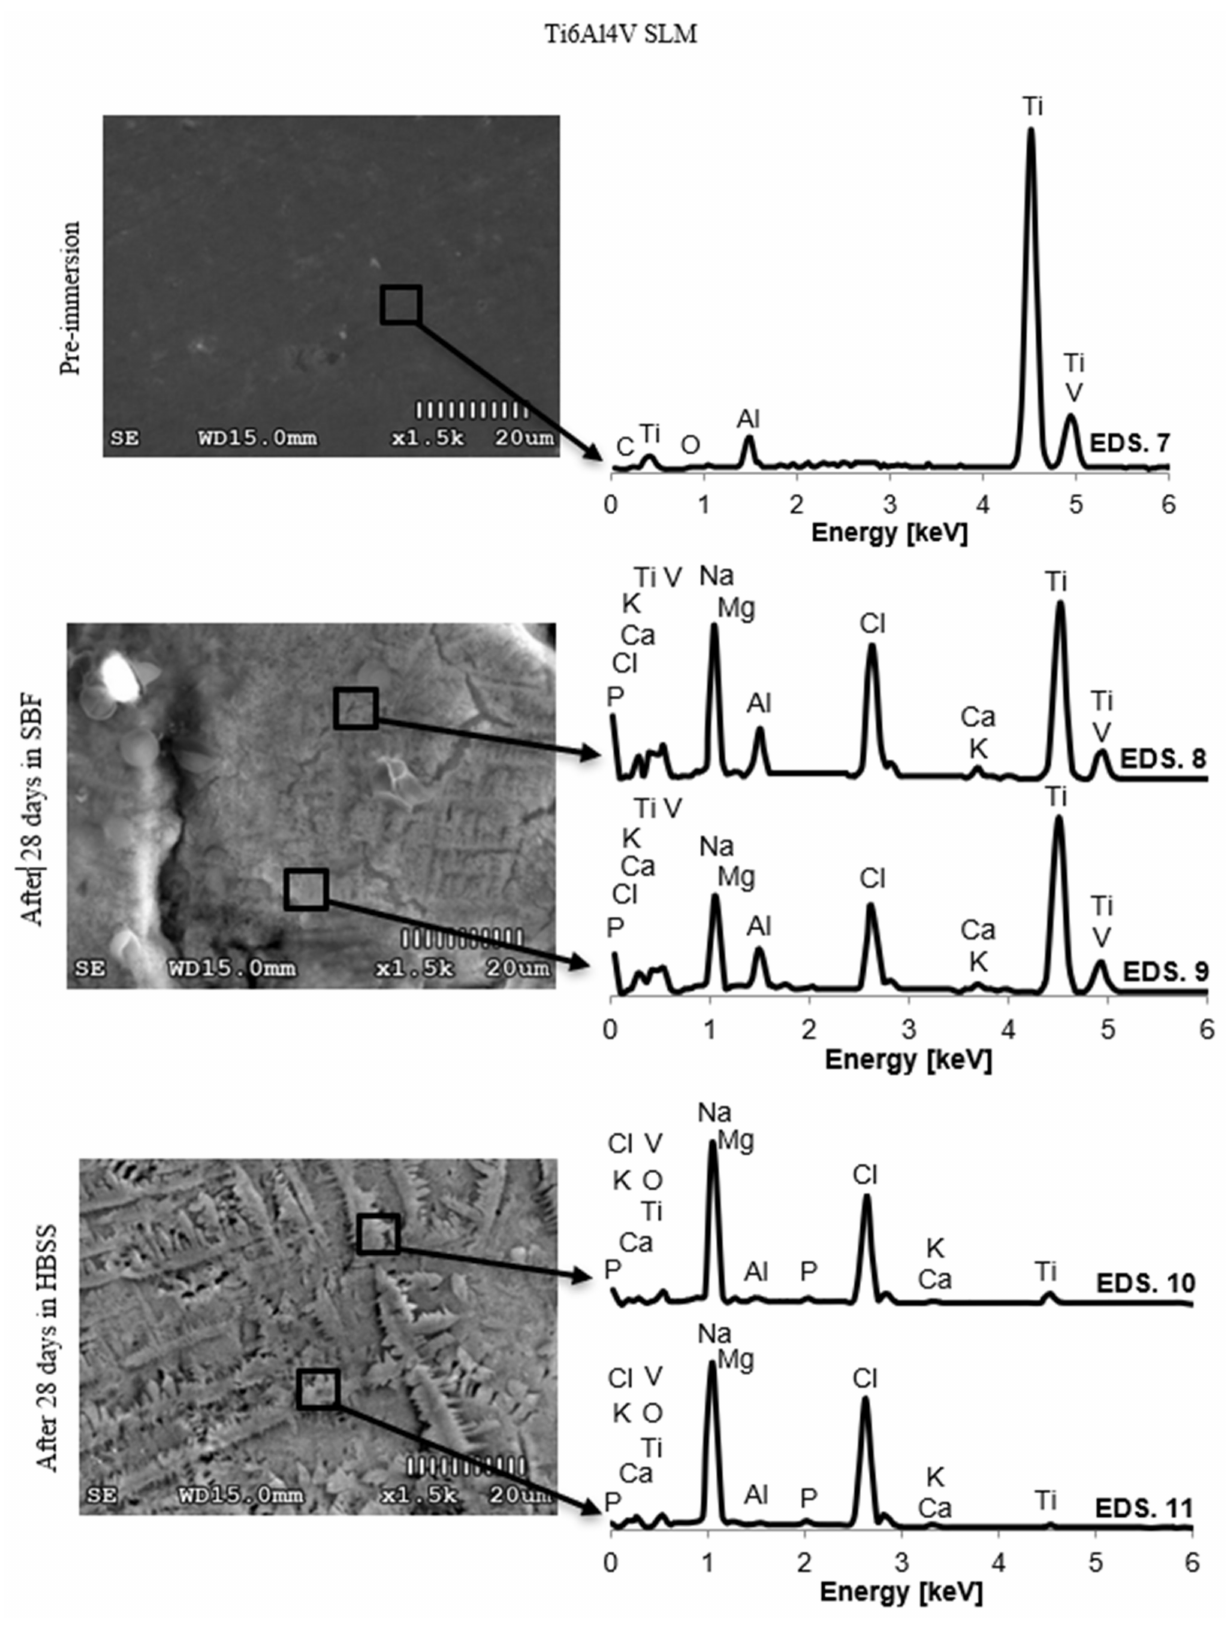
Figure 6. Spectrum EDS of Ti6Al4V SLM before and after 28 days of material samples immersion in SBF and